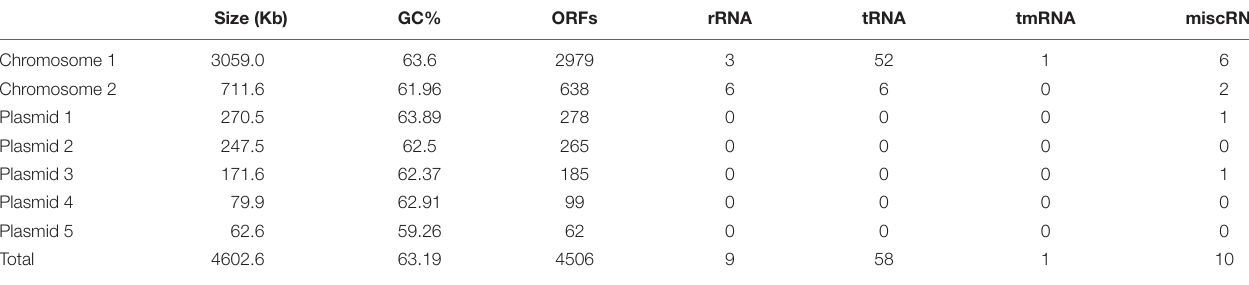
TABLE 3 | General features of the C1 T